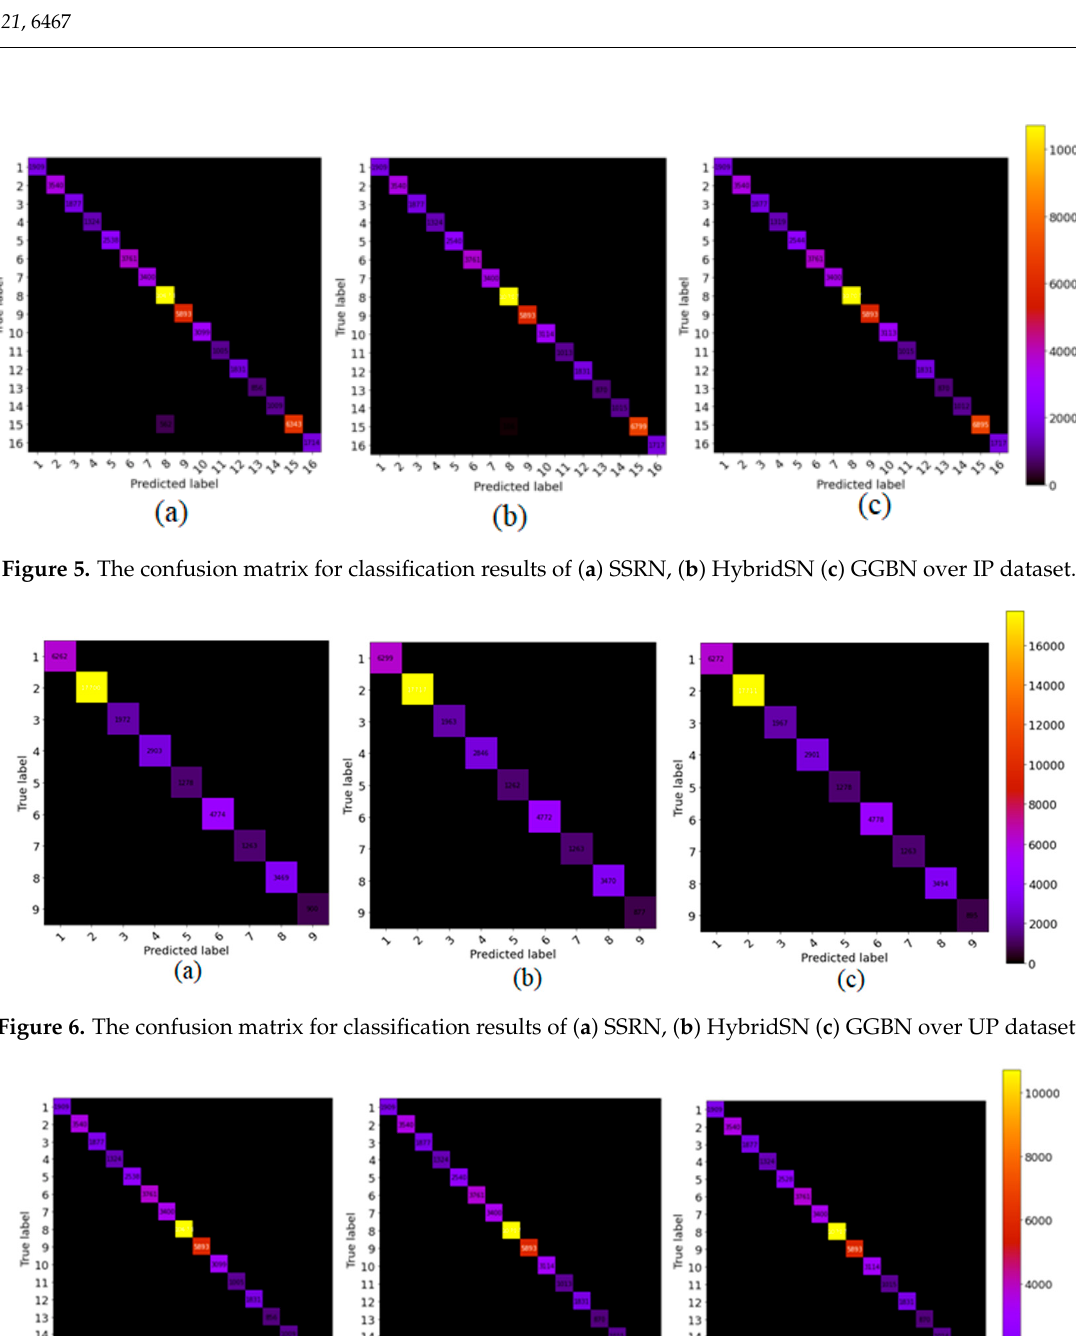
Sensors 2021 , 21 , x FOR PEER REVIEW